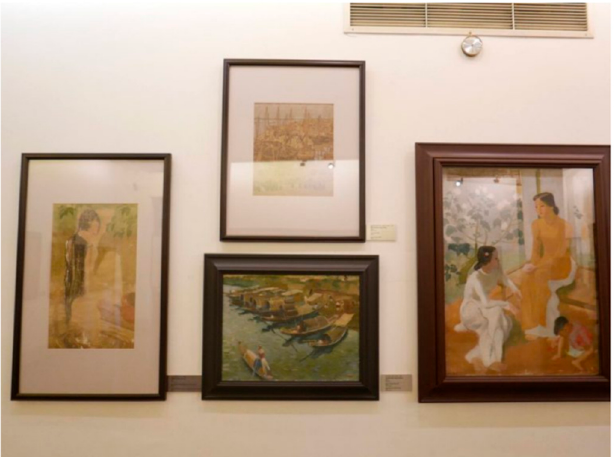
Figure A6. The Thuyen tren song huong —To Ngoc Van hang at the Vietnam Museum of Fine Arts. The image was sourced from website nghethuatxua.vn (Anthony 2016).